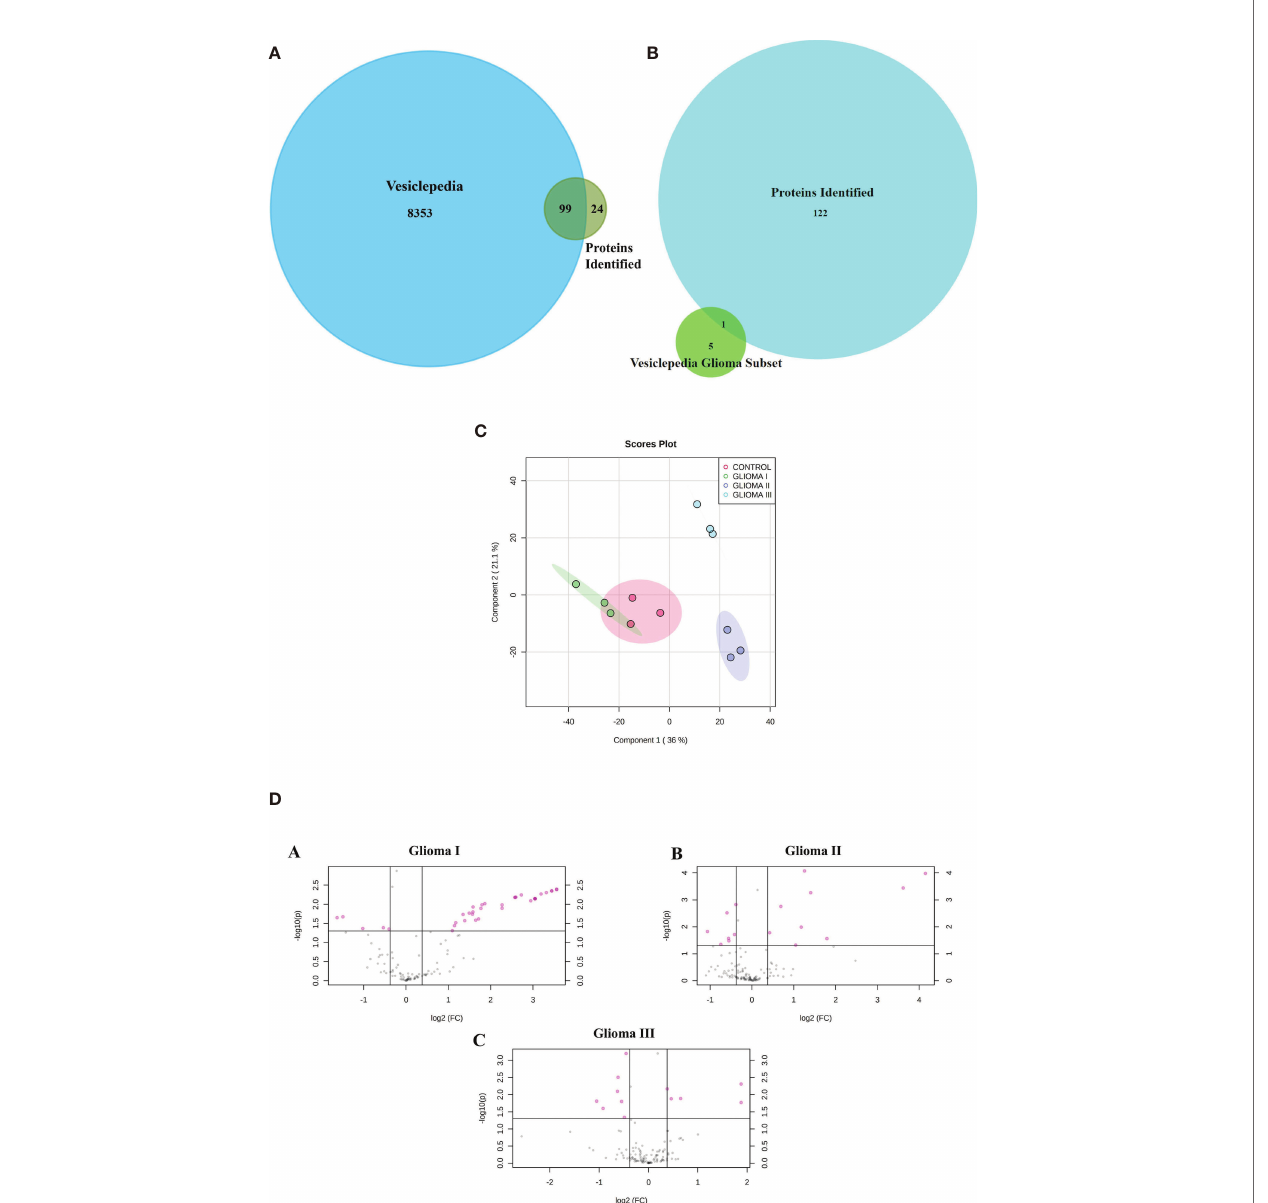
FIGURE 2 | Proteomic analysis using iTRAQ labelling. (A) Venn diagram indicating the protein identi fi ed in our study and those reported in Vesiclepedia. (B) Venn diagram indicating proteins identi fi ed in the present study along with the previously reported in Vesiclepedia from exosomes in glioma. (C) pLSDA analysis of replicate runs of each pooled sample. (D) (A – C) Differential expression Analysis volcano plots of log2 (fold change) VS log10 (p value) indicates the proteins (colored in pink) showing statistically signi fi cant difference abundance in the different grades of glioma as compared to